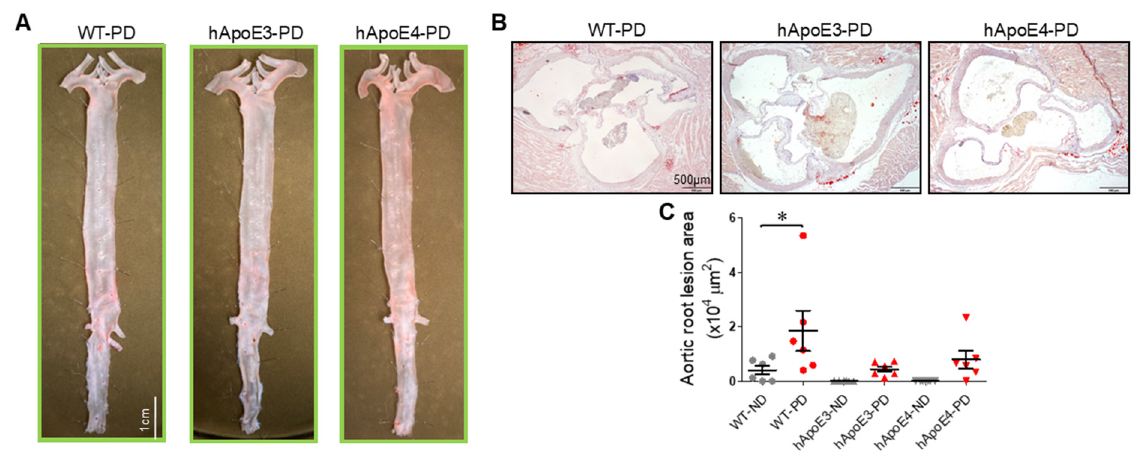
Figure 8. Atherosclerotic lesion after 4 months of the PD. ( A ) Representative photographs of Oil Red O-stained aortas from WT, hApoE3, and hApoE4 rats after 4-month PD feeding are shown. ( B ) Representative photomicrographs of the plaque lesion in cross-sectional aortic roots are shown. ( C ) Plaque lesion areas of cross-sectional aortic roots of these rats were quantified. (n = 6 per group, two-way ANOVA followed by a Bonferroni post hoc test. *, p < 0.05).